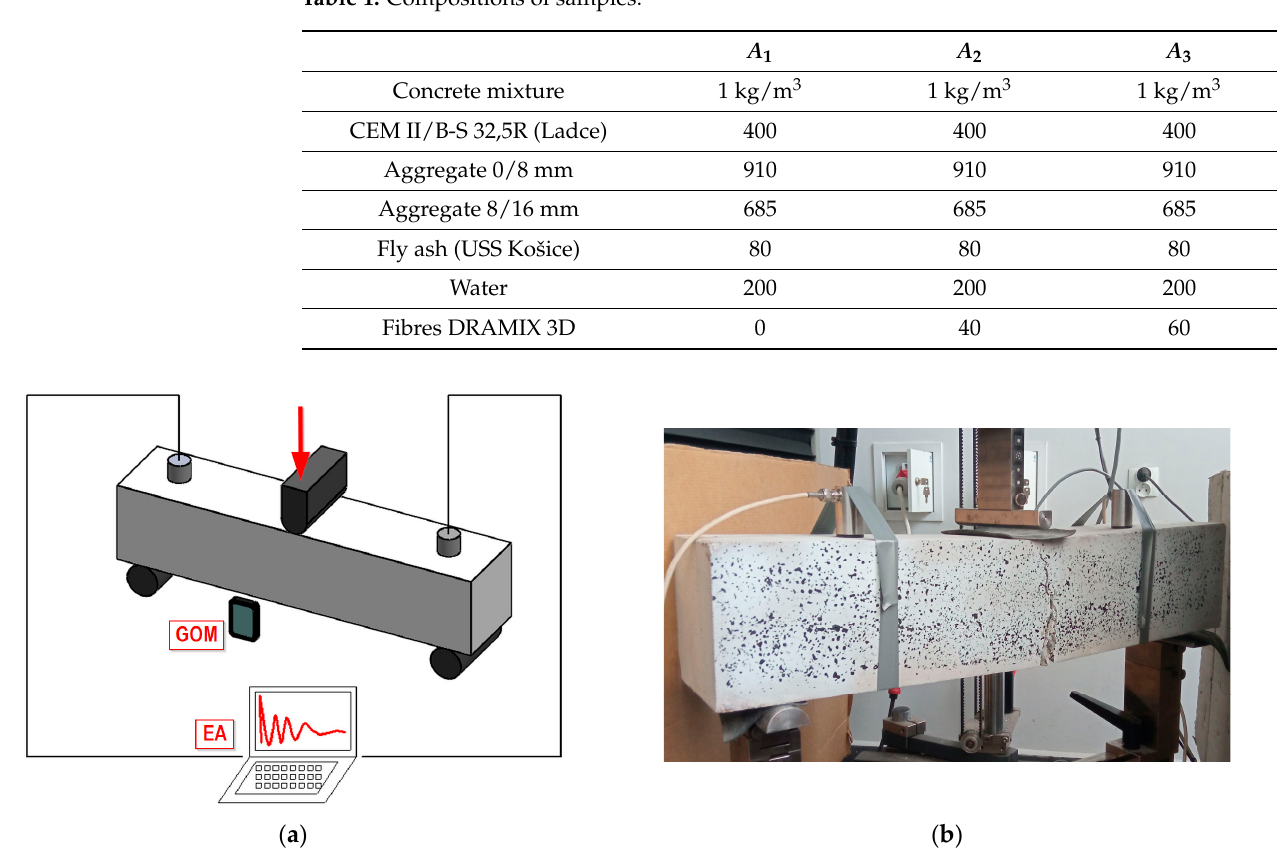
Figure 1. Test stand: ( a ) scheme; ( b )